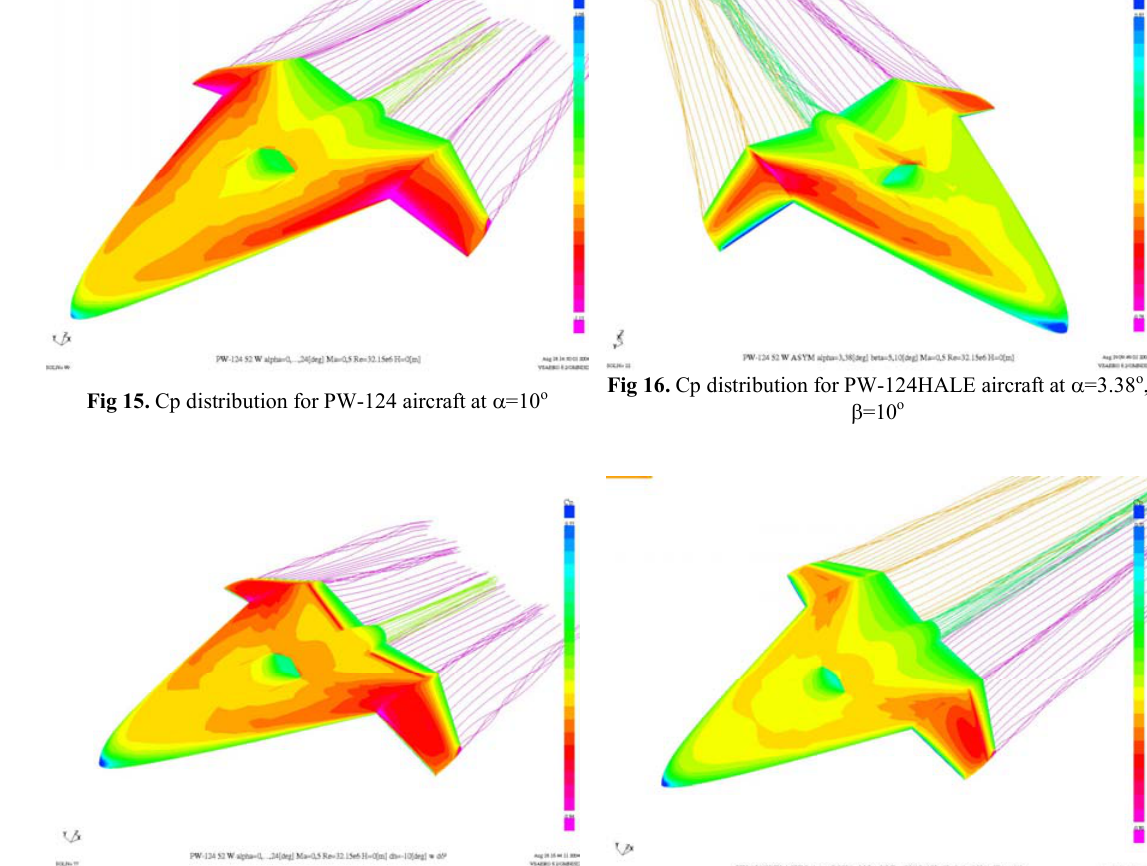
Fig 18. Cp distribution for PW -124 HALE aircraft at